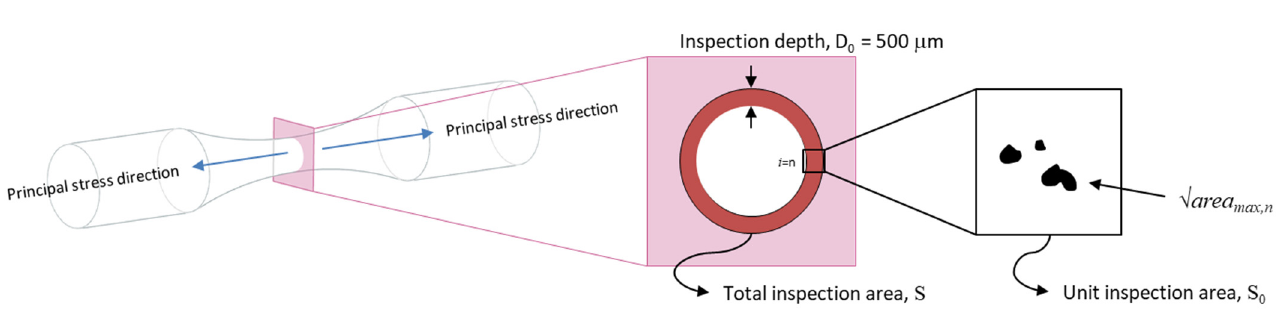
Figure 2. Observed surfaces of rotary bending specimens. ( a ) Scanning electron microscopy; ( b ) optical microscopy, Model S-4300 from Hitachi (Tokyo, Japan); and ( c ) mirror-polished surface.